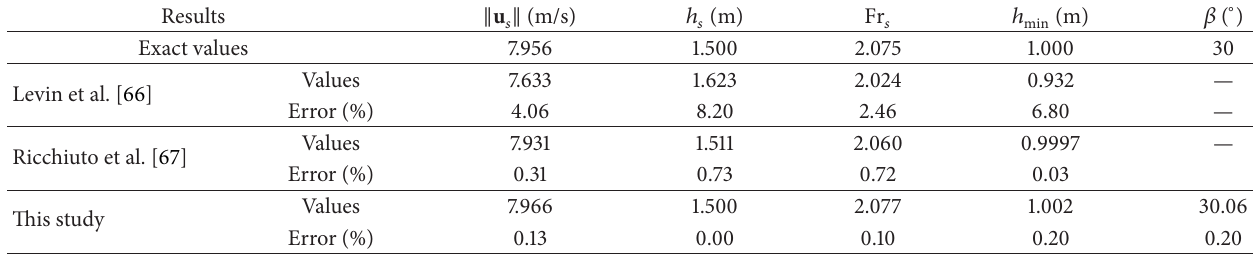
Table 5: Comparison of numerical results by oblique hydraulic